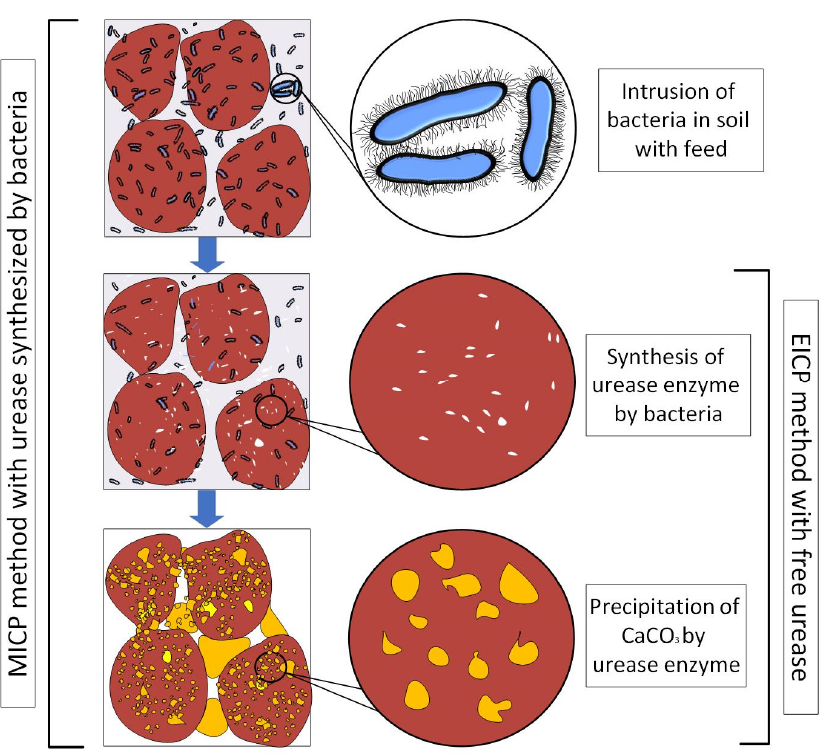
Figure 1. Mechanisms of microbial-induced calcite precipitation (MICP) and enzyme-induced calcite Precipitation (EICP) in the CaCO 3 precipitation.